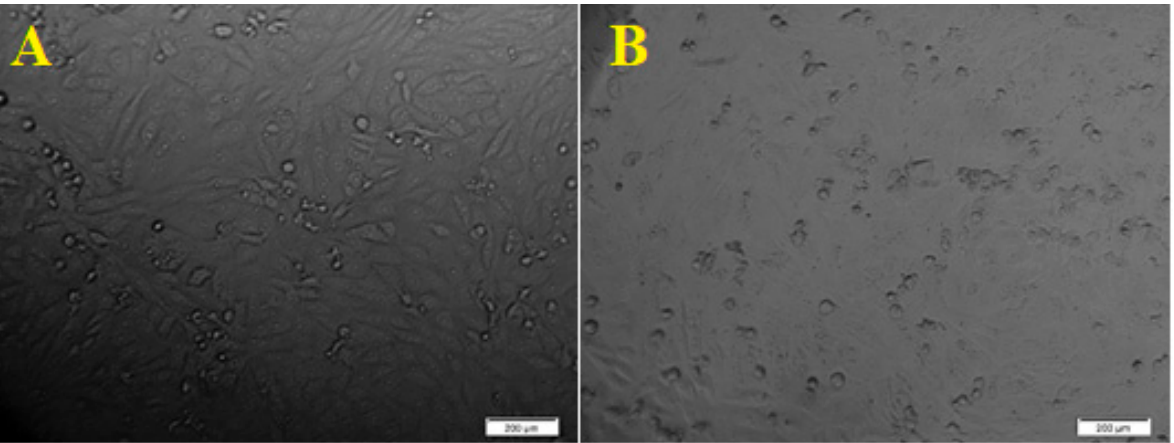
Figure 6. Cancer cell viability percentage on HCT-116 cell line at various concentrations of ZnO NPs.